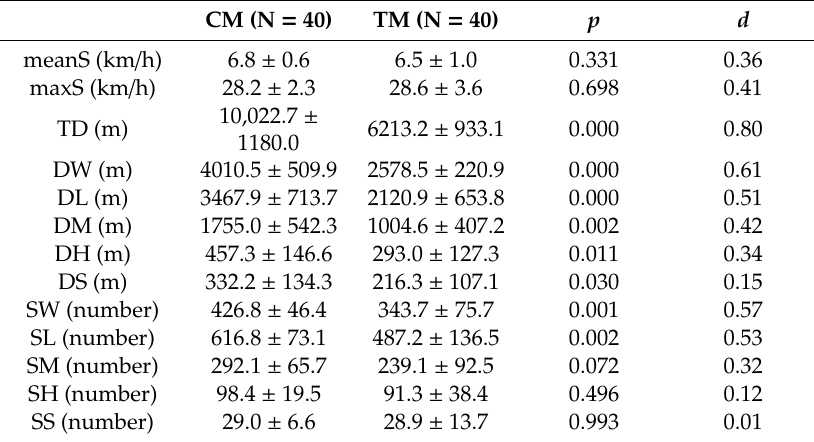
Table 2. Paired tests of physical responses of soccer players in CM and